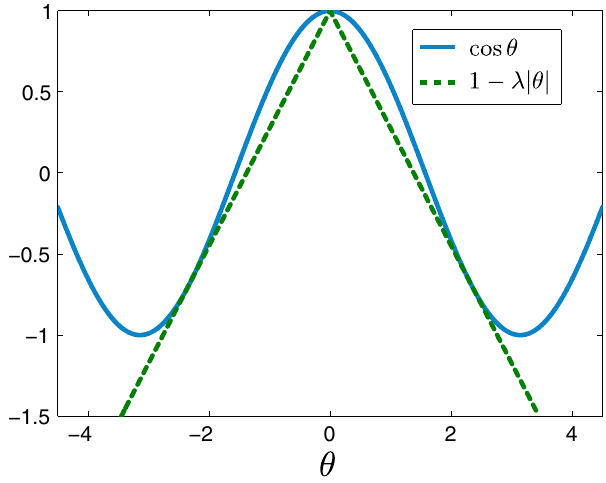
FIG. 3. A lower bound on the cosine